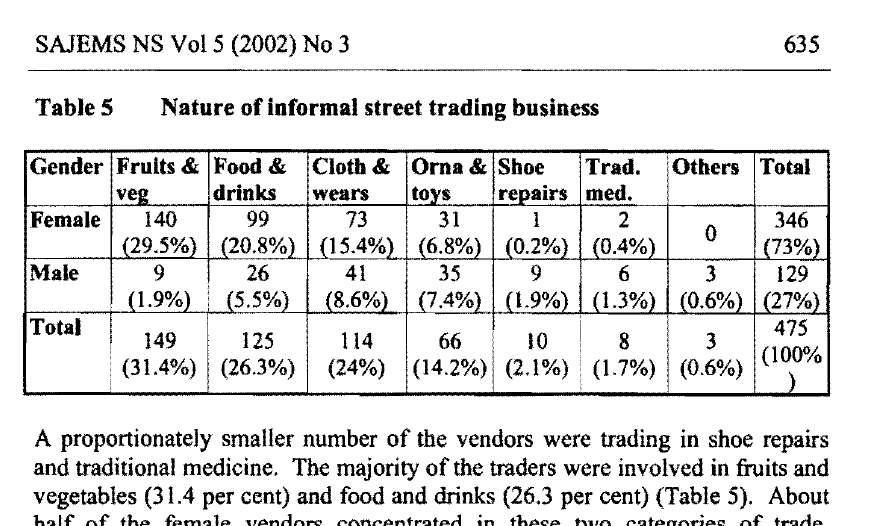
Distribution of street business activity by regions